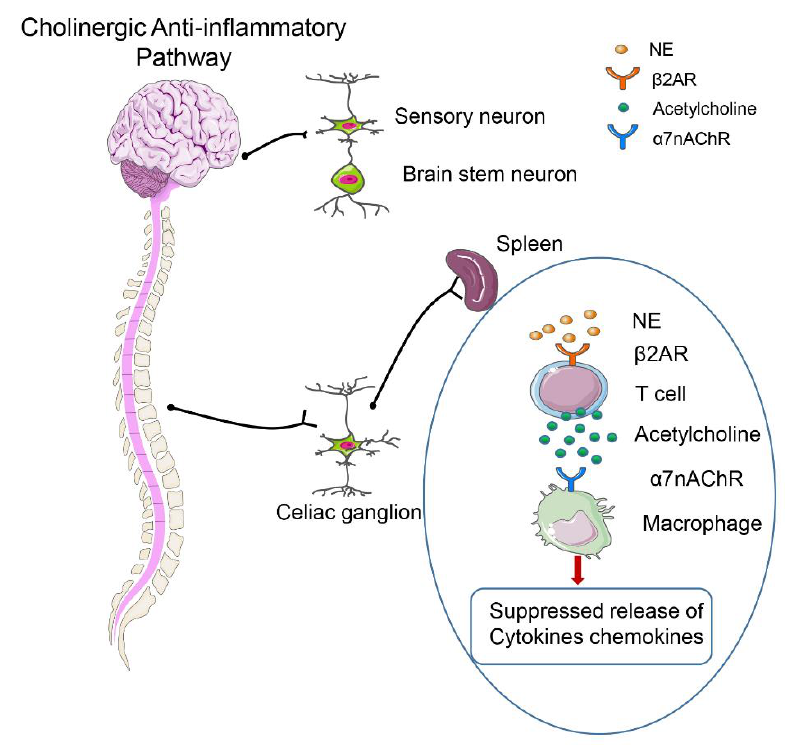
Figure 3. The function of the cholinergic anti-inflammatory pathway (CAP) in sepsis.